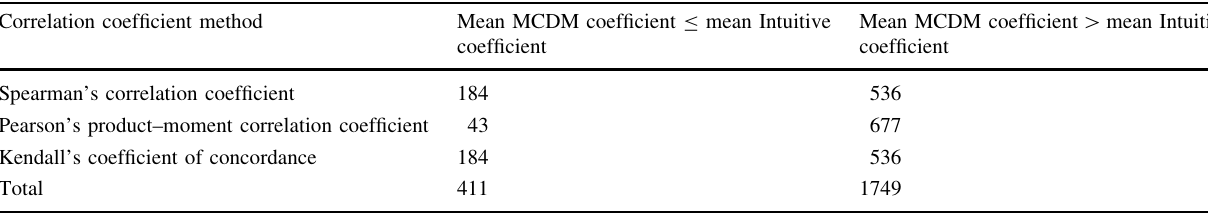
Table 24 Summary of hypothesis 2 tests Correlation coefficient